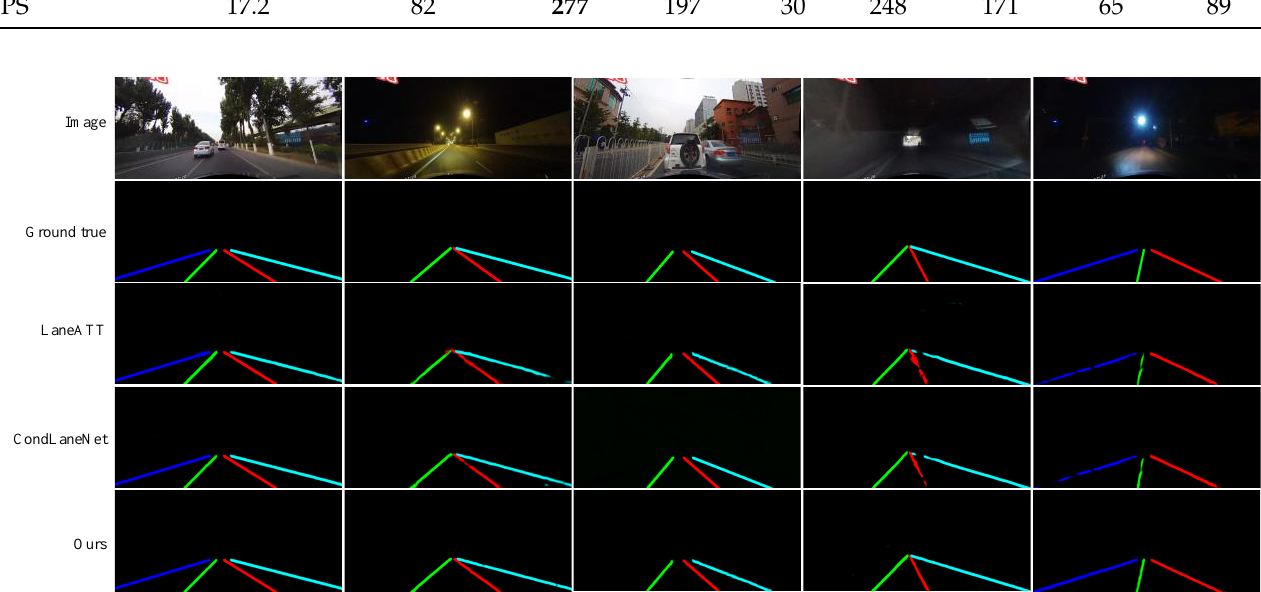
Figure 12. Some examples of the qualitative comparison results of our work on the CULane dataset are shown. In some difficult scenarios, because our method explicitly considers the segmentation in the previous moment, it can sometimes produce better